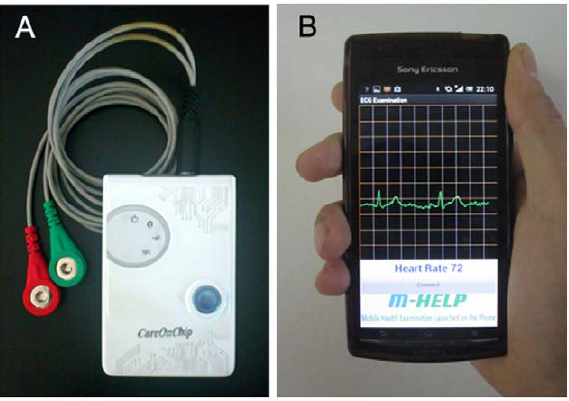
Figure 2. A portable system for ECG monitoring on the mobile phone. (A) The miniaturized wireless ECG module; (B) The ECG monitoring displayed on the mobile phone.